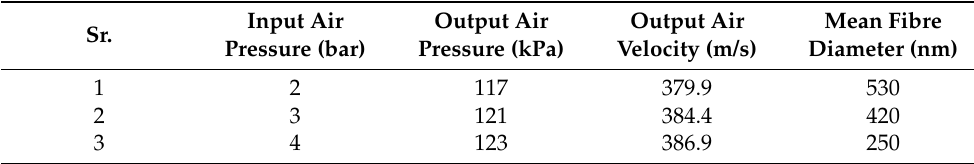
Table 1. Various airflow parameters and resultant mean fibre